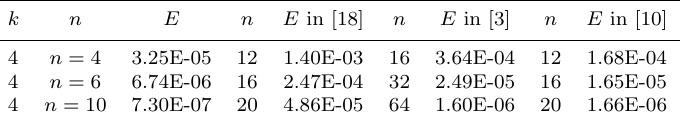
Table 2. Maximum absolute error for Example 2